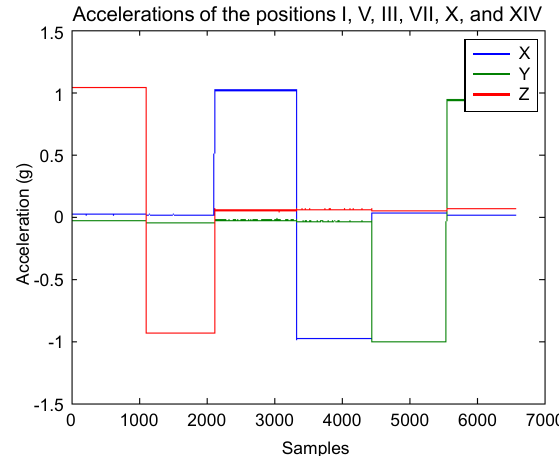
Figure 11. Measurements of the key positions after removing artifacts caused by the device manipulation.